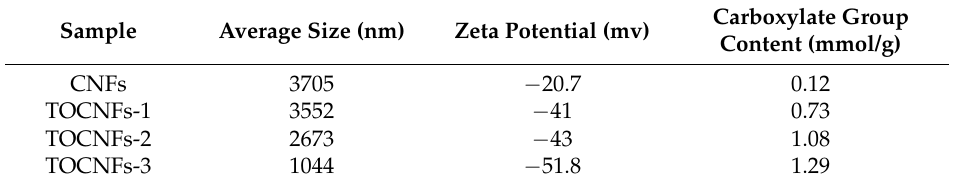
Table 1. Characteristics of cellulose nanofibrils before and after TEMPO